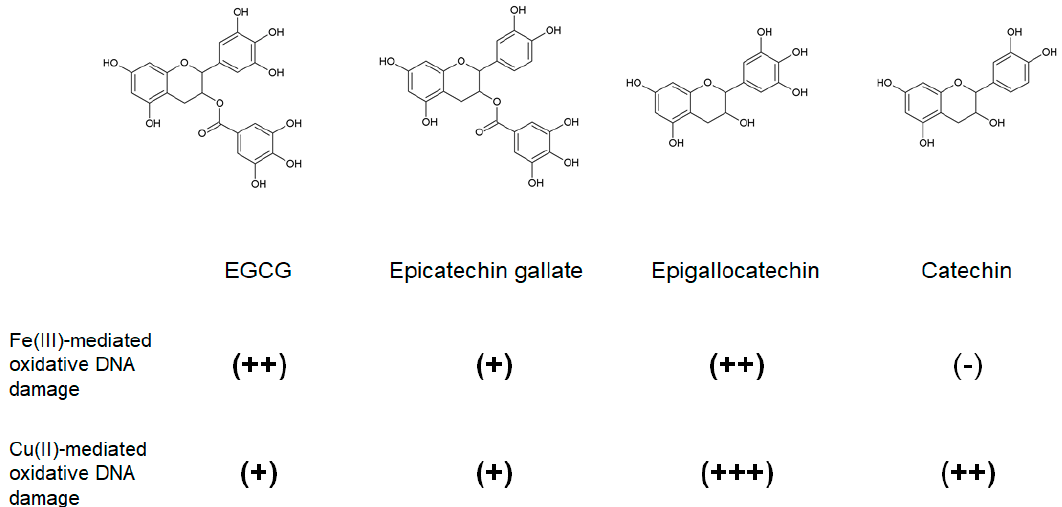
Figure 5. Fe(III)- and Cu(II)-mediated DNA damage caused by green tea polyphenols. Three tea polyphenols with pyrogallol moieties (EGCG, epicatechin gallate, and epigallocatechin) can induce Fe(III)- and Cu(II)-mediated oxidative DNA damage although, catechins, which harbor no pyrogallol moieties, only cause Cu(II)-mediated oxidative DNA damage. ( +++ ), ( ++ ), ( + ), and (-) represent the extent of DNA damage. EGCG: epigallocatechin gallate